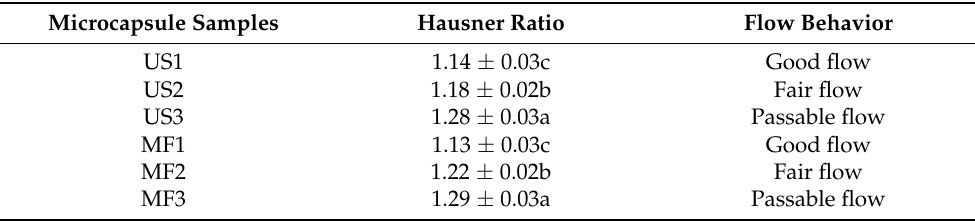
Table 2. Flow behavior of spray-dried microcapsules having KBPI and KC (1:0.1, w / w ) as wall materials loaded with different amounts of